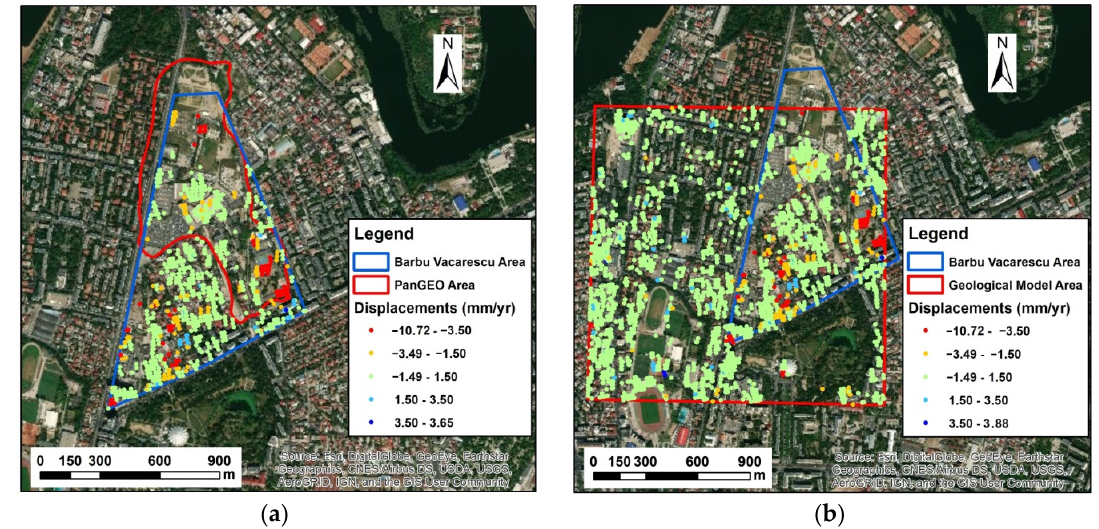
Figure 8. PSI in Barbu Vacarescu area ( a ) Red limit represents the identified subsidence area in the PANGEO project [26]; blue limit represents the subsidence area identified in this study. ( b ) Red limit represents the geological model area; blue limit represents the subsidence area identified in this study. Map generated in Esri ® ArcMap™ 10.3. Base map source: ESRI World Imagery.